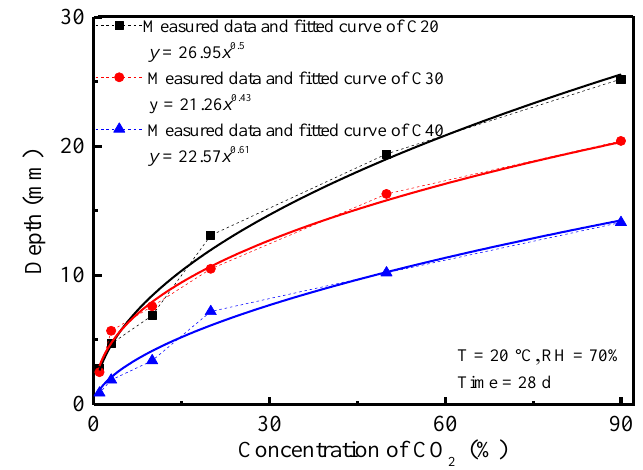
Figure 5. Relation curves between the carbonation depth of concrete and CO 2 concentration.